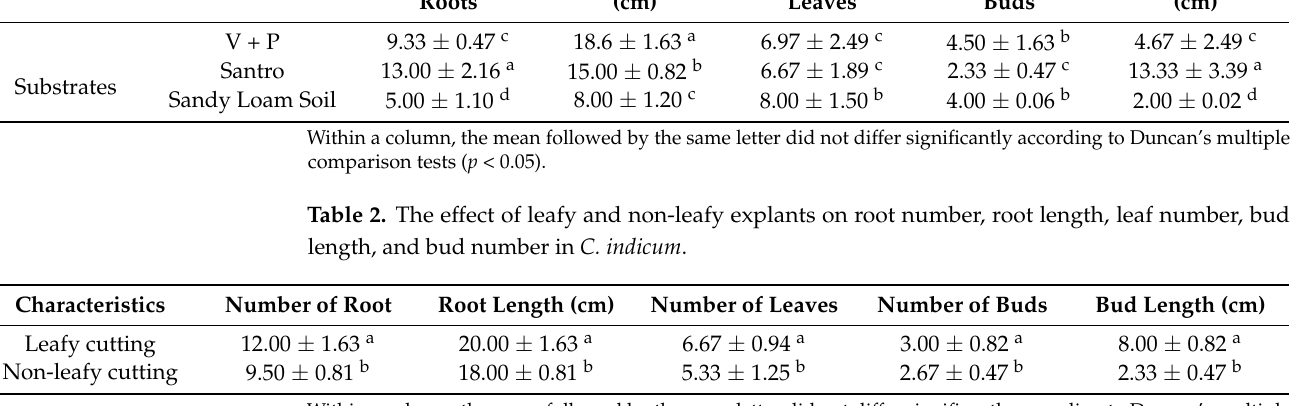
Figure 5. Rooting and sprouting of leafy and non-leafy stem cutting of C. indicum in the substrate